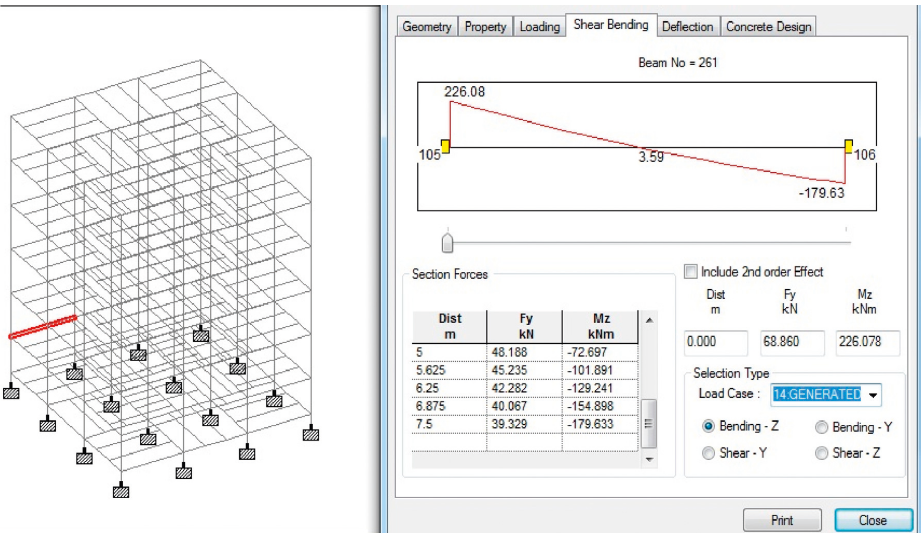
Figure 3: Bending moment for lightweight concrete of the selected member.